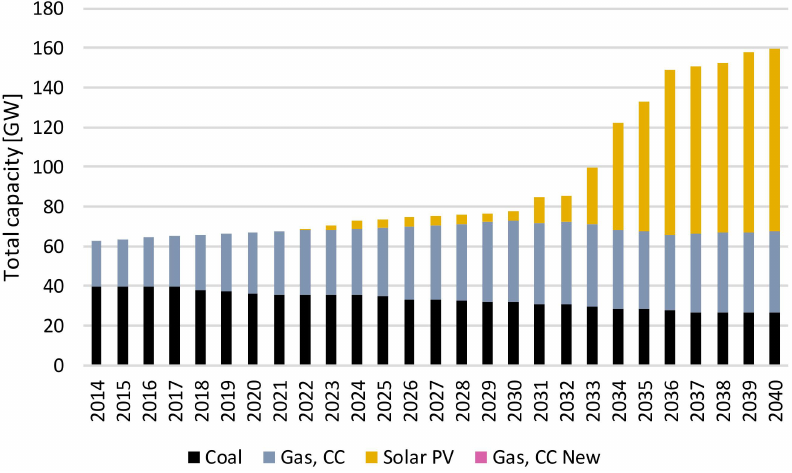
Figure 18. Total capacity (GW) in the REF scenario, in cases of decreasing solar PV capital costs and increasing CO 2 tax—without code